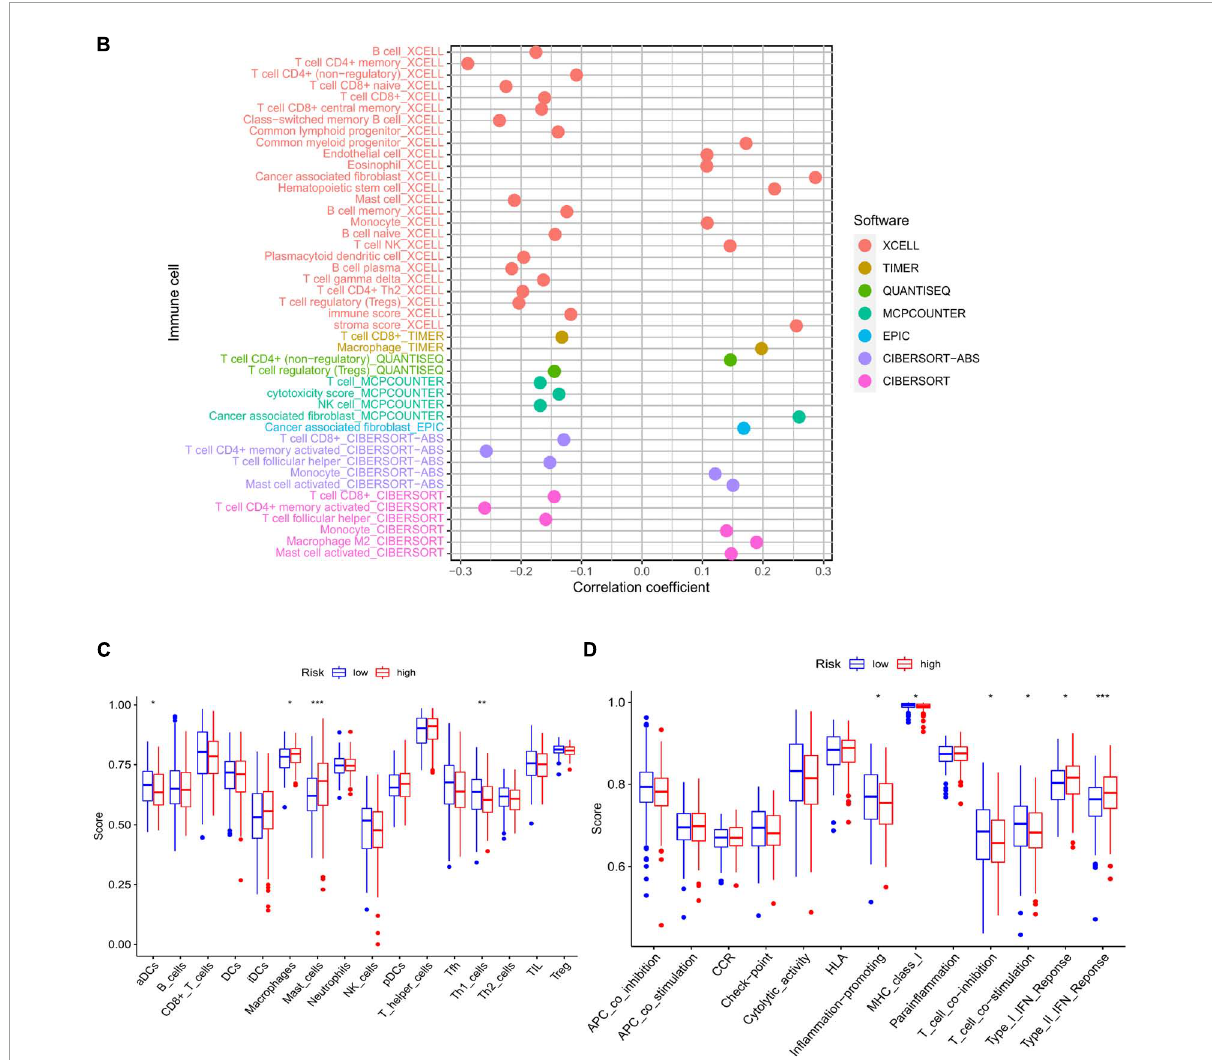
FIGURE6 (A) Correlation between risk score and immune cells. (B) XCELL, TIMER, QUANTISEQ, MCPCOUNTER, EPIC, and CIBERSORT to analyze the immune landscape of patients with CRC. (C,D) ssGSEA analysis. CRC, colorectal cancer; GSEA, gene set enrichment